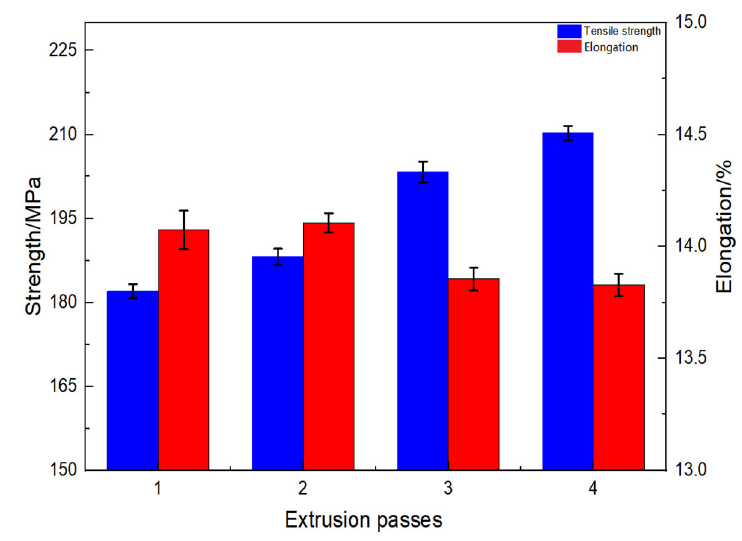
Figure 14. Tensile properties of 10 vol.% HEA composites under different extrusion passes at room temperature (26 °C).